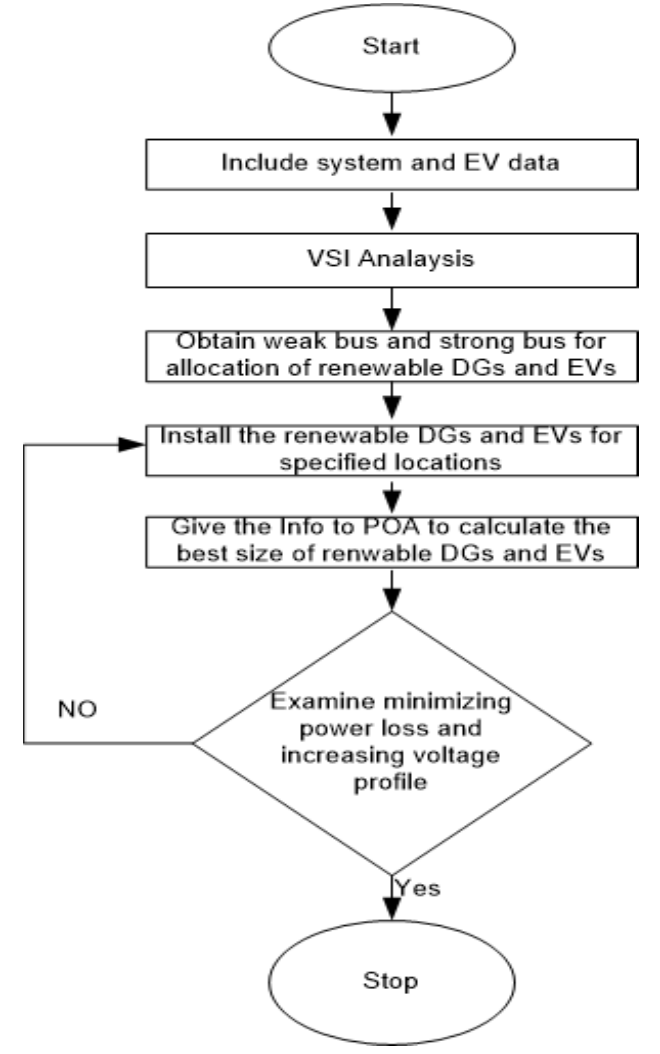
Figure 4. Flow chart steps for Scheduling EVs.